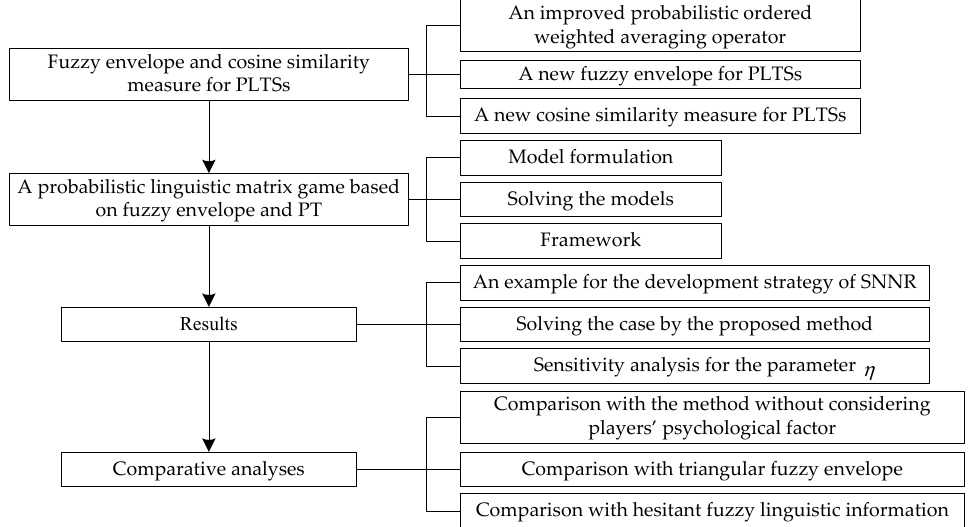
Figure 1. Flowchart of the proposed method.